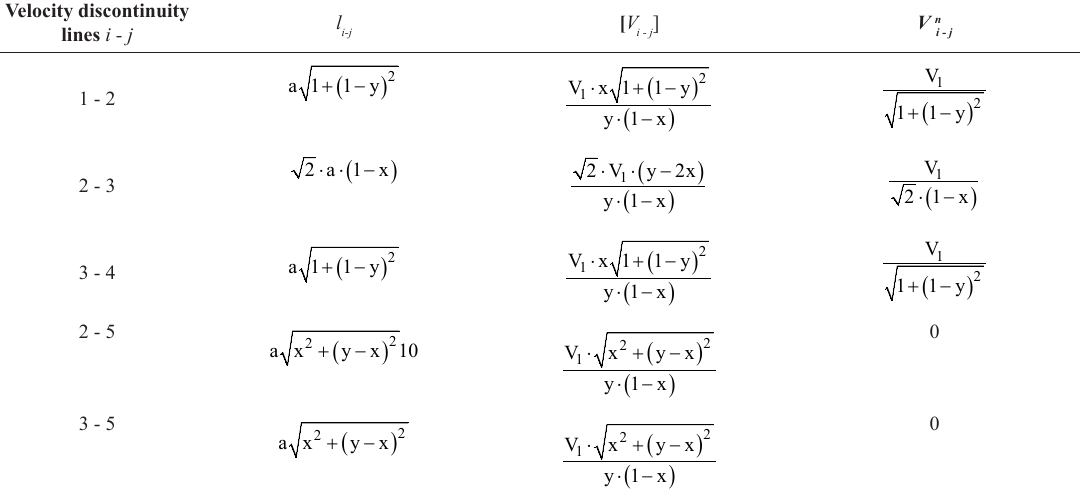
Table 3. The lines of discontinuity and sliding velocities for ECAE die with 2θ=90 ° ( x=h/a and y=H/a ) in Figures 4-5. Velocity discontinuity lines i -